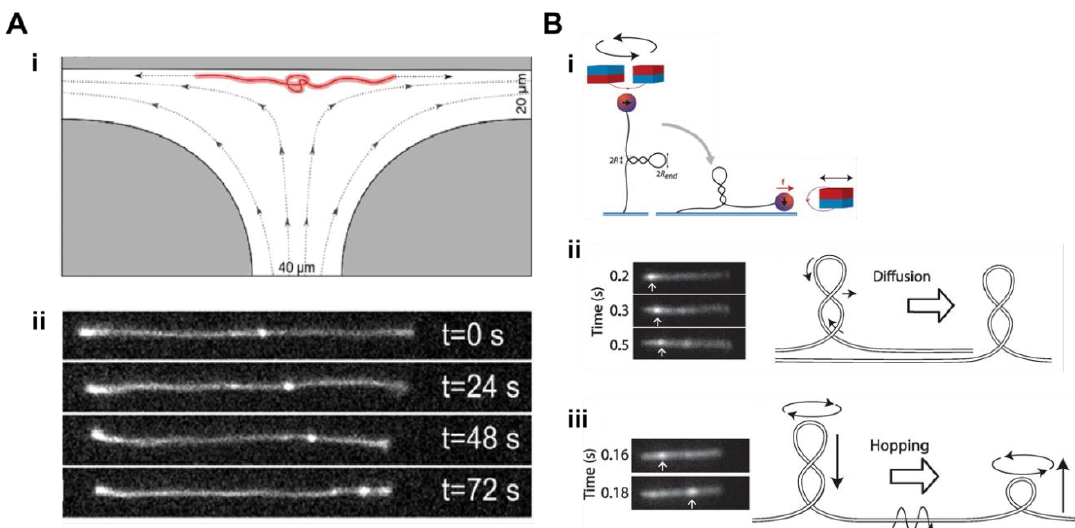
Figure 3. Fluorescence visualisation of topological intermediates of DNA. ( A ) Motion of knots in DNA: ( i ) A microfluidic T-junction flow cell with a diverging electric field stretches knotted linear DNA molecules at its stagnation point. ( ii ) Representative images of a single DNA molecule at four time points as a DNA knot (bright fluorescent spot) translates towards one end of the DNA molecule (reproduced with permission from [56]). ( B ) Dynamics of DNA supercoils: ( i ) Visualisation of plectonemes by fluorescence microscopy combined with magnetic tweezers. Individual DNA molecules are supercoiled by rotating a pair of magnets and subsequently pulled sideways by another magnet. ( ii ) Fluorescence images of plectoneme diffusion along an individual supercoiled DNA molecule stained with SxO. ( iii ) Fluorescence images of a plectoneme hopping along an individual supercoiled DNA molecule stained with SxO (reproduced with permission from [66]).